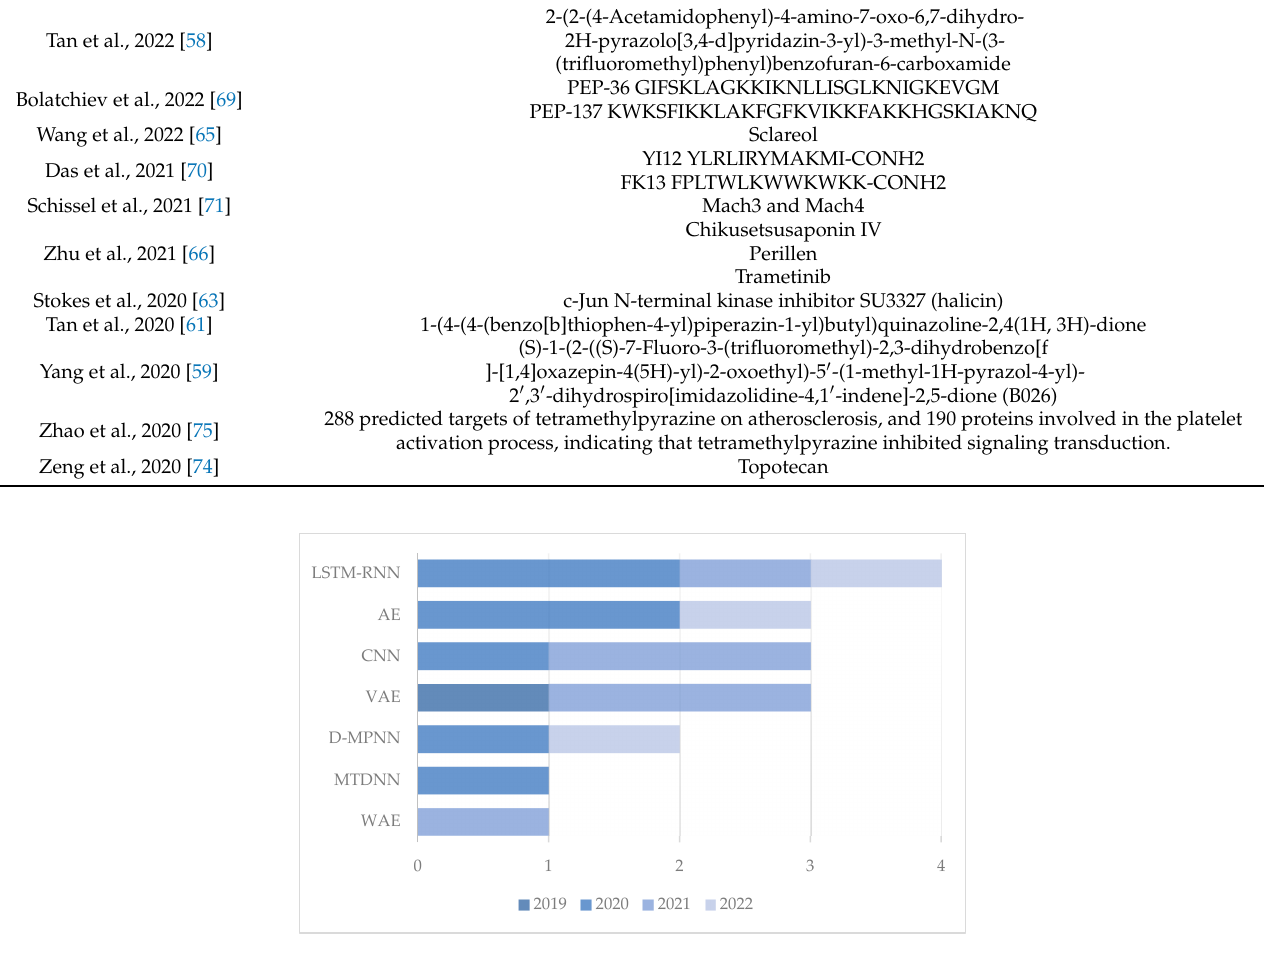
Figure 7. The relative frequencies per year of the deep learning models described in the present review.